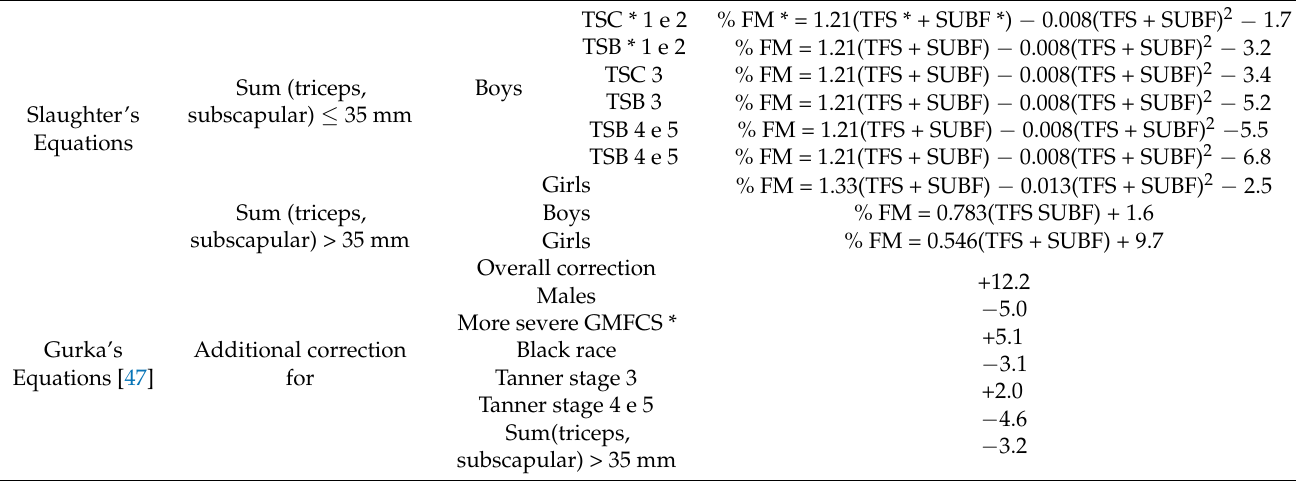
Table 3. Original Slaughter equations and corrections for children with CP.